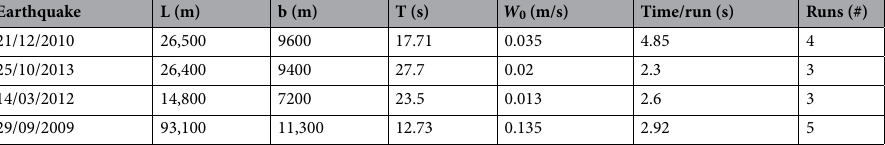
Table 6. Properties retrieved by the inverse problem model: number of runs (sets of solutions, 10 solutions each set) carried by the model and the average computational time taken by each of the runs.